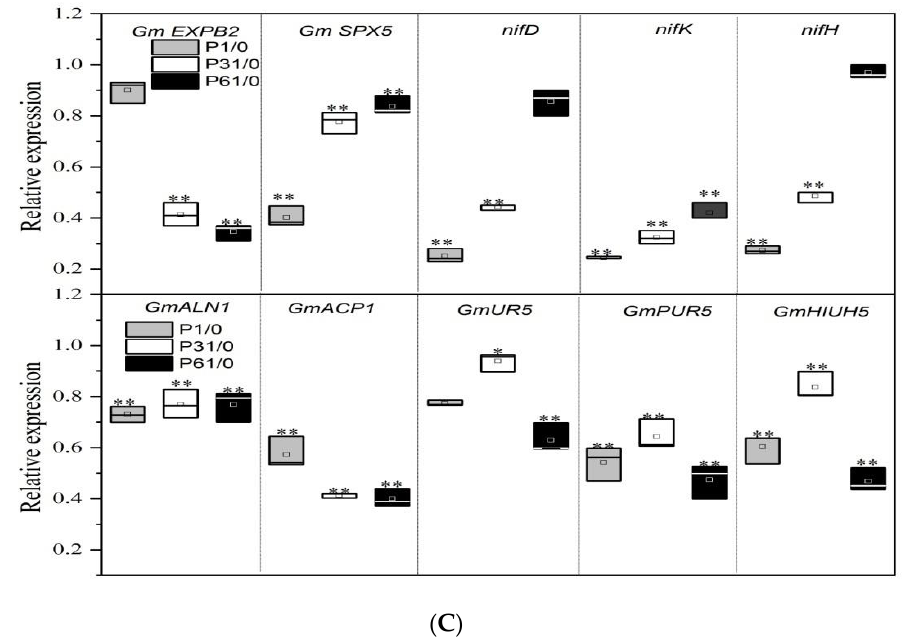
Figure 3. ( A ) Relative gene expression on the phosphorus-application side (the P31/0 as control). ( B ) Relative gene expression on the phosphorus-free side(the P31/0 as control). ( C ) Relative expression of phosphorus-free genes side (phosphorus-application side as a control). Effects of P supply on the relative expression levels of key genes related to nodulation and nitrogen fixation on both sides of the dual-root soybean. In ( A ) and ( B ), different lowercase letters indicate the significant differences between treatments at the 5% level. In ( C ), ** denotes a significant difference between the P+ side and the P − side, with P** indicating a significant difference at the 1% level; GmEXPB2 is nodulation-related key gene; nifD , nifH , and nifK are regulatory key genes of nitrogen fixation; GmALN1, GmACP1, GmUR5, GmPUR5, GmHIUH5 . The expression levels of GmEXPB2 , GmSPX5 , nifD , nifK , GmALN1 , GmACP1 , GmUR5,